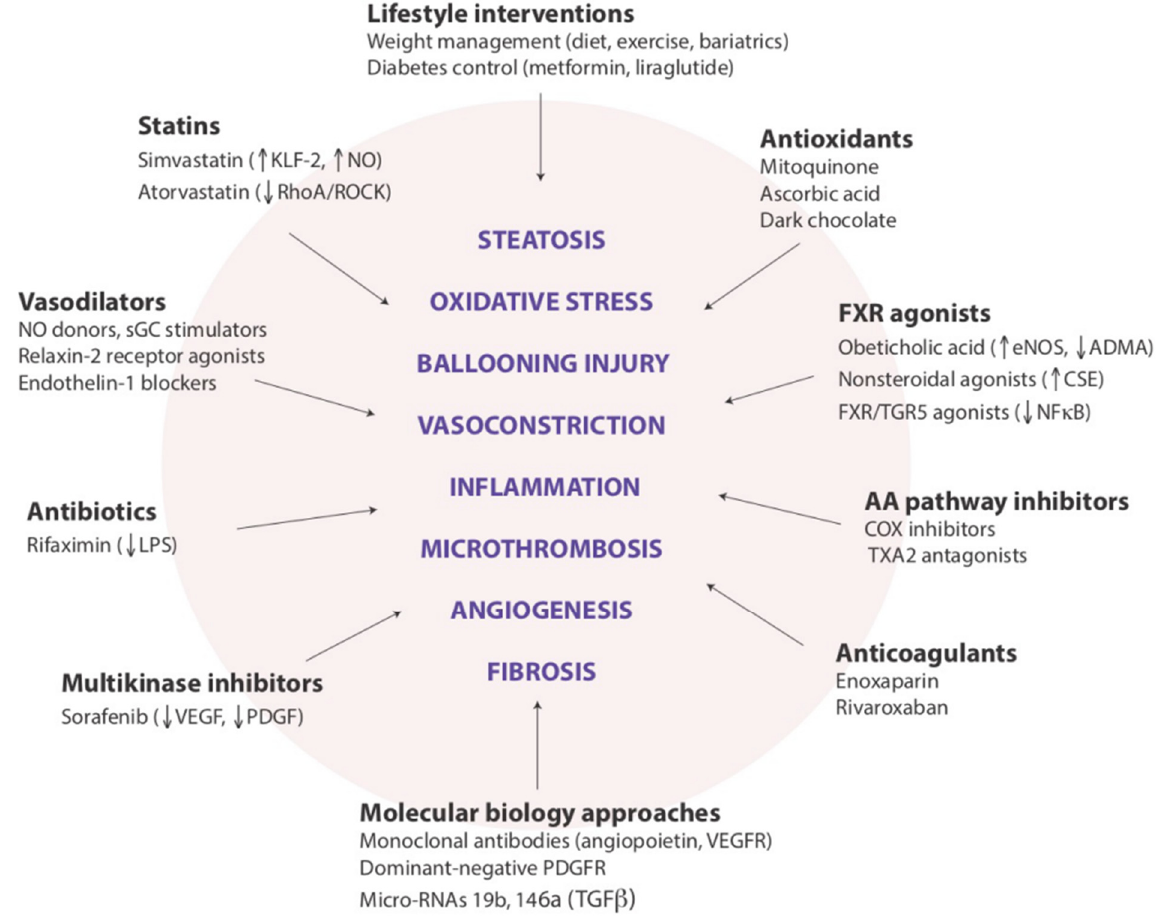
Figure 2. Potential targets for modulating intrahepatic vascular resistance in NAFLD. Legend to Figure 2: This cartoon illustrates the variety of drug approaches to be evaluated for addressing the functional components in the pathophysiology of portal hypertension associated with NAFLD. We believe that these drug classes and examples, beyond their promising indications for preventing the progression of liver disease, may also prove to be beneficial for preventing the development of CKD among individuals with NAFLD (reprinted from Ryou et al. [102]).